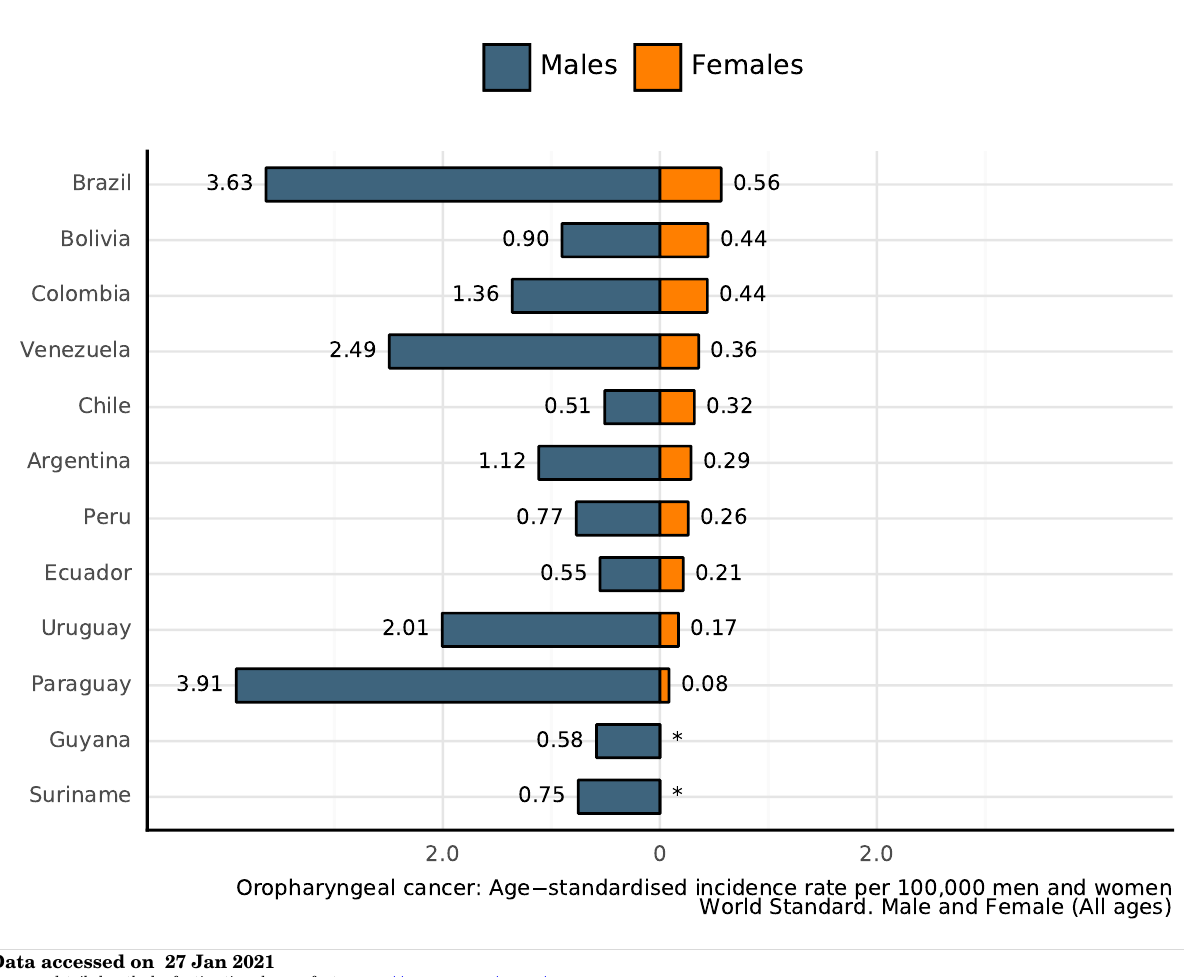
Figure 90: Age-standardised incidence rates of oropharyngeal cancer of Peru (estimates for 2020)